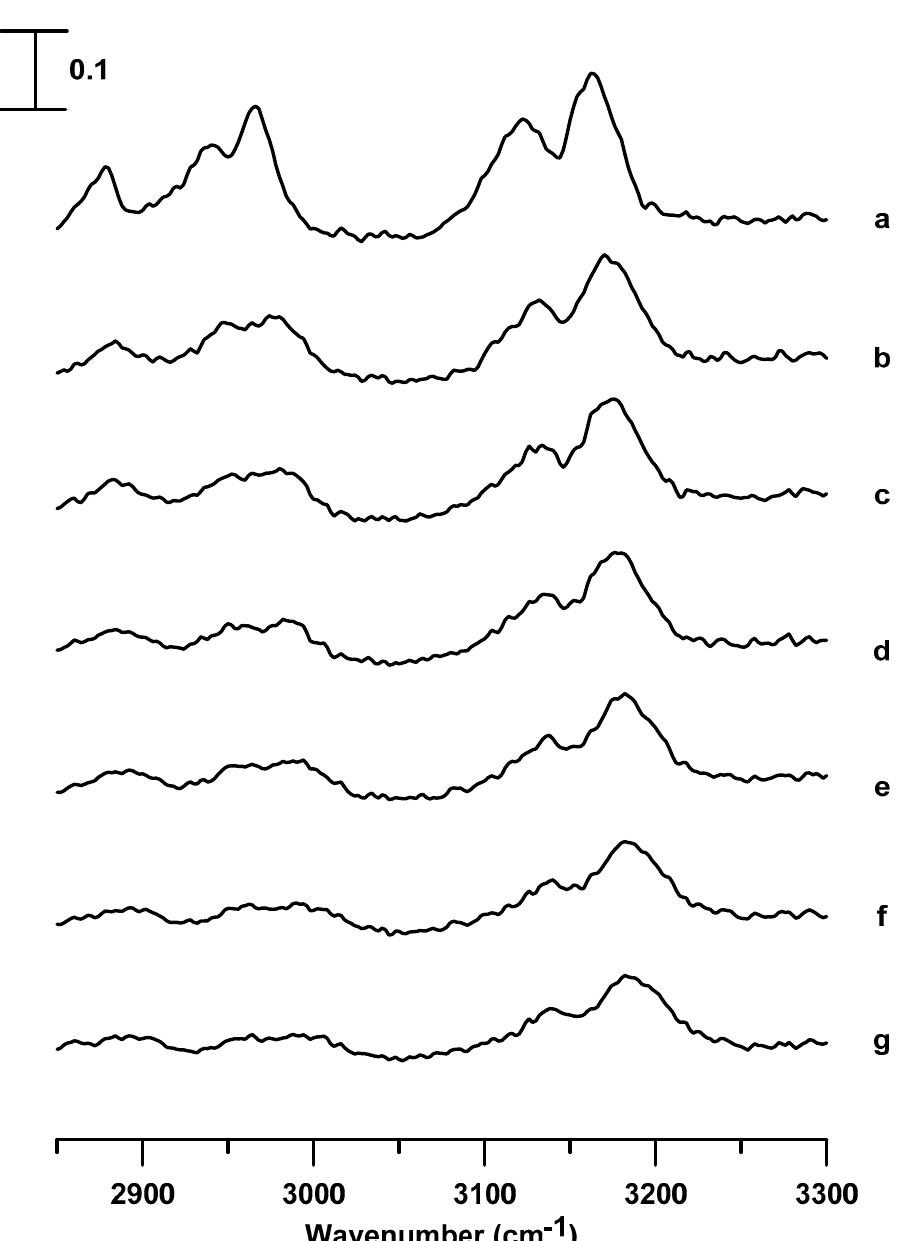
Figure 5. Infrared spectra of the pure [C 4 C 1 Im][BF 4 ] obtained at (a) ambient pressure and at (b) 0.4, (c) 0.7, (d) 1.1, (e) 1.5, (f) 1.8, and (g) 2.5 GPa.